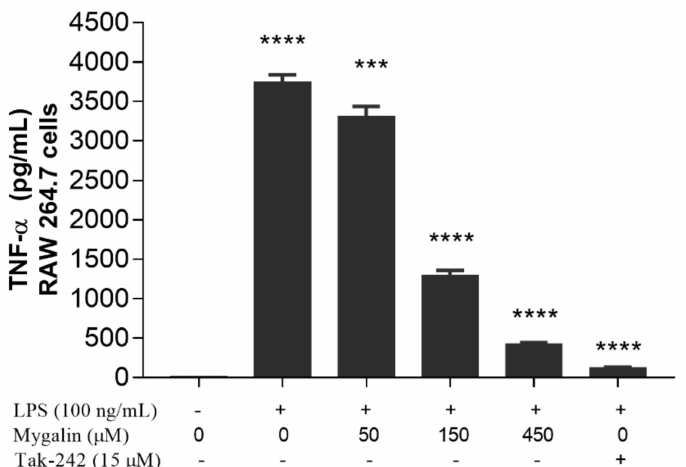
Figure 5. E ff ects of mygalin on TNF- α levels in cells stimulated with lipopolysaccharide (LPS). The levels of TNF- α secreted in RAW cells were measured 24 h after stimulation with LPS. The cells were pretreated for 1 h with mygalin, and TAK-242 was used as a positive control as an LPS blockade. The data represent the mean ± SEM of three independent experiments carried out in triplicate and the p value was calculated using multiplex comparisons with the Tukey test (*** p < 0.001, **** p < 0.0001 compared to